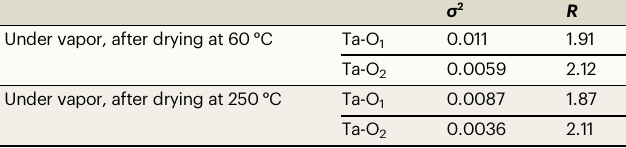
Table 1 | Debye – Waller factor ( σ 2 ) and interatomic distance ( R ) from FEFF fi tting of EXAFS shown in Supplementary Fig. 18,